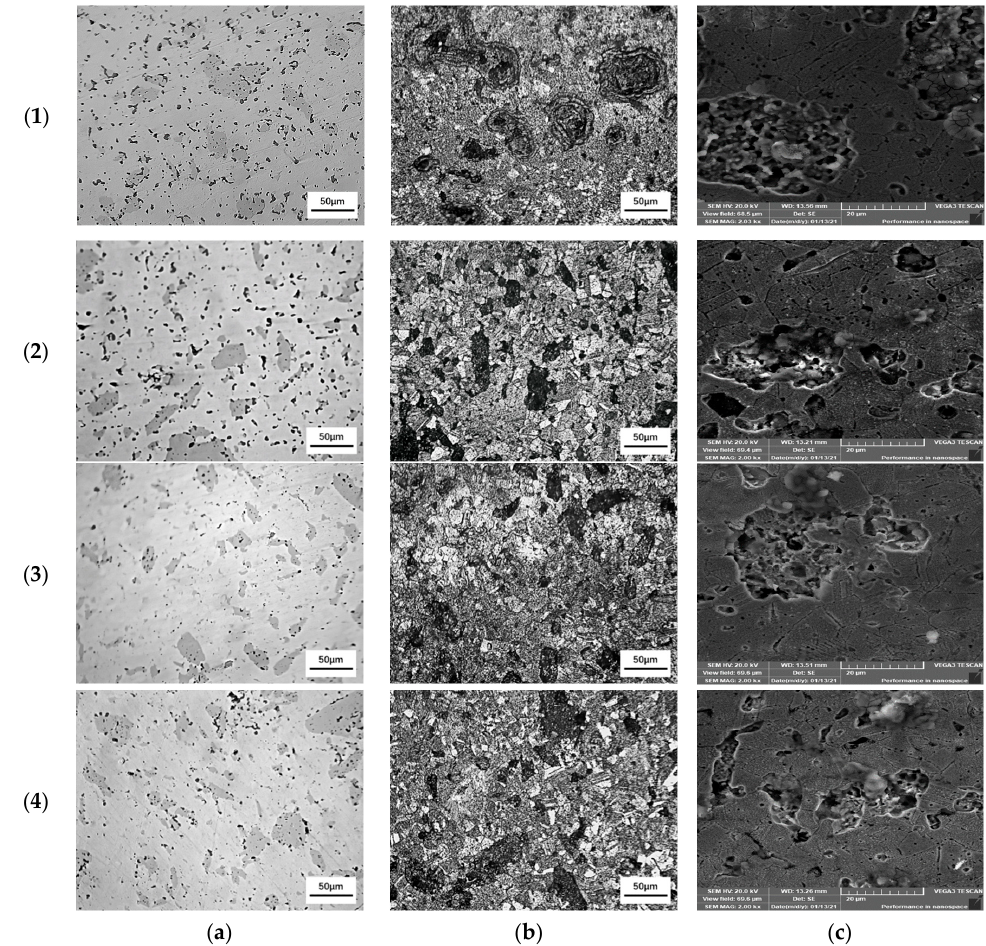
Figure 6. Optical micrographs ( a ) without and ( b ) with chemical etched, and ( c ) SEM micrographs of Cu–15Fe sintered samples at 200 MPa: ( 1 ) blank, ( 2 ) PW, ( 3 ) SA, and ( 4 ) PW+SA.